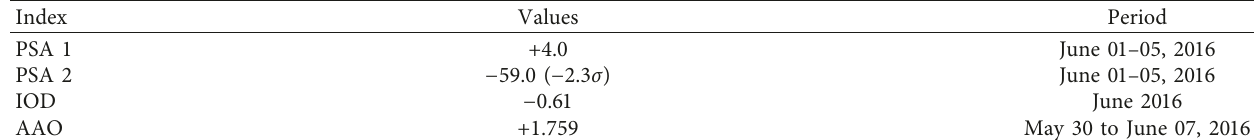
Table 1: Values of the climate indices analyzed. σ is the standard deviation.